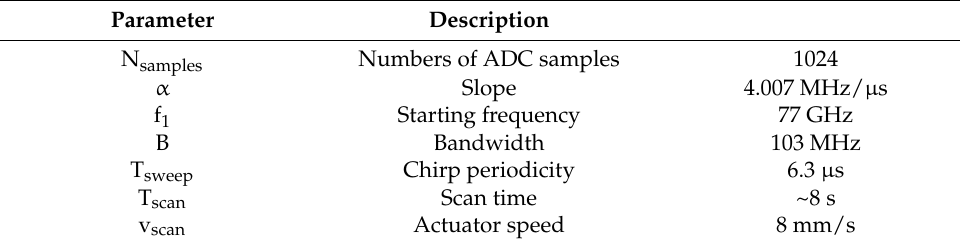
Figure 14. Radar setup ( a ) during the measurement campaign at Vespucci bridge ( b ). The radar was at 6.50 m below the bridge and the left pillar was at about 52 m from the radar. The radar was exactly in the center of the roadway. Radar parameters are reported in Table 2. Table 2. Radar parameters during the Vespucci bridge monitoring.